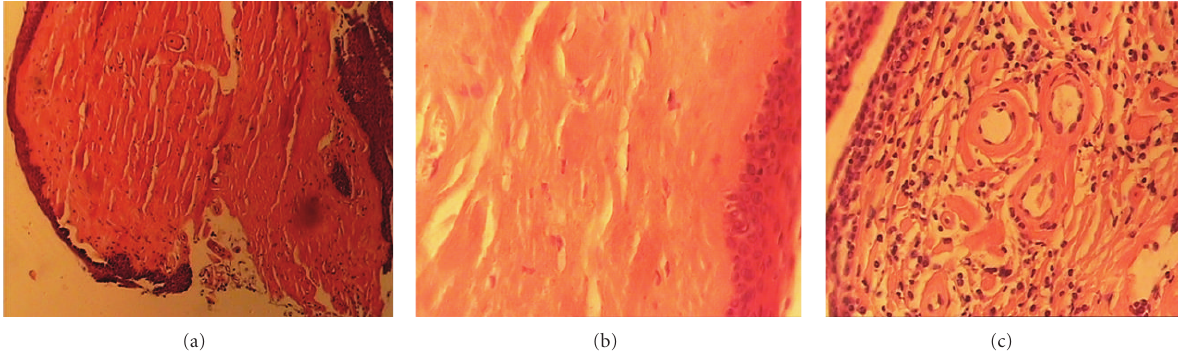
Figure 4: Biopsy of vocal fold (H&E): (a) and (b) deposition of hyaline material ( × 20 and × 400, resp.). (c) “Onion skin” appearance around blood vessels ( ×